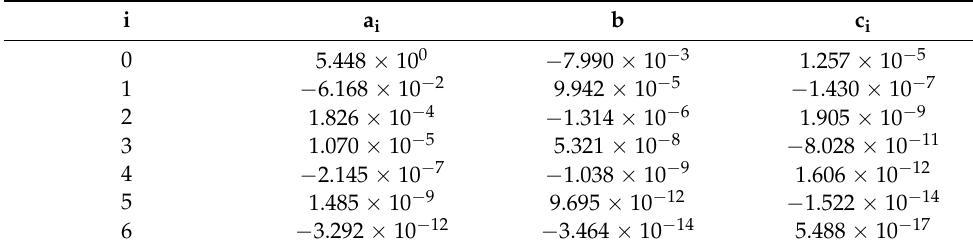
Table A20. Coefficients of the H 2 O-LiCl + LiNO 3 specific heat